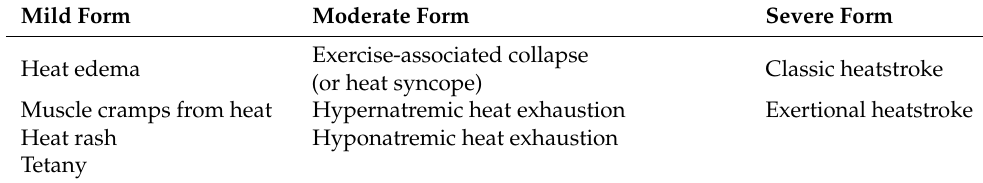
Table 2. Clinical patterns of heat